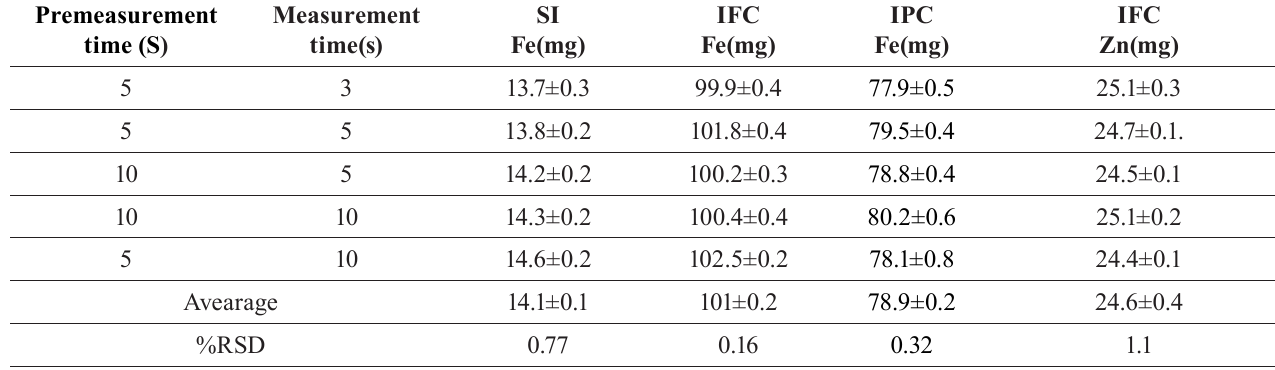
TABLE VI - Iron and zinc levels from the microwave-digested samples at different premeasurement times and measurement times